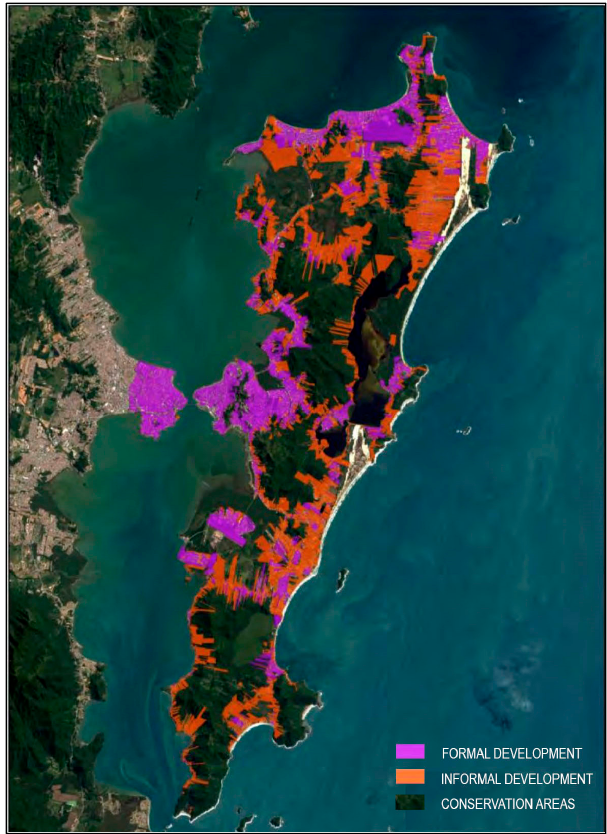
Figure 7. Formal and informal urban development, and conservation areas [73].